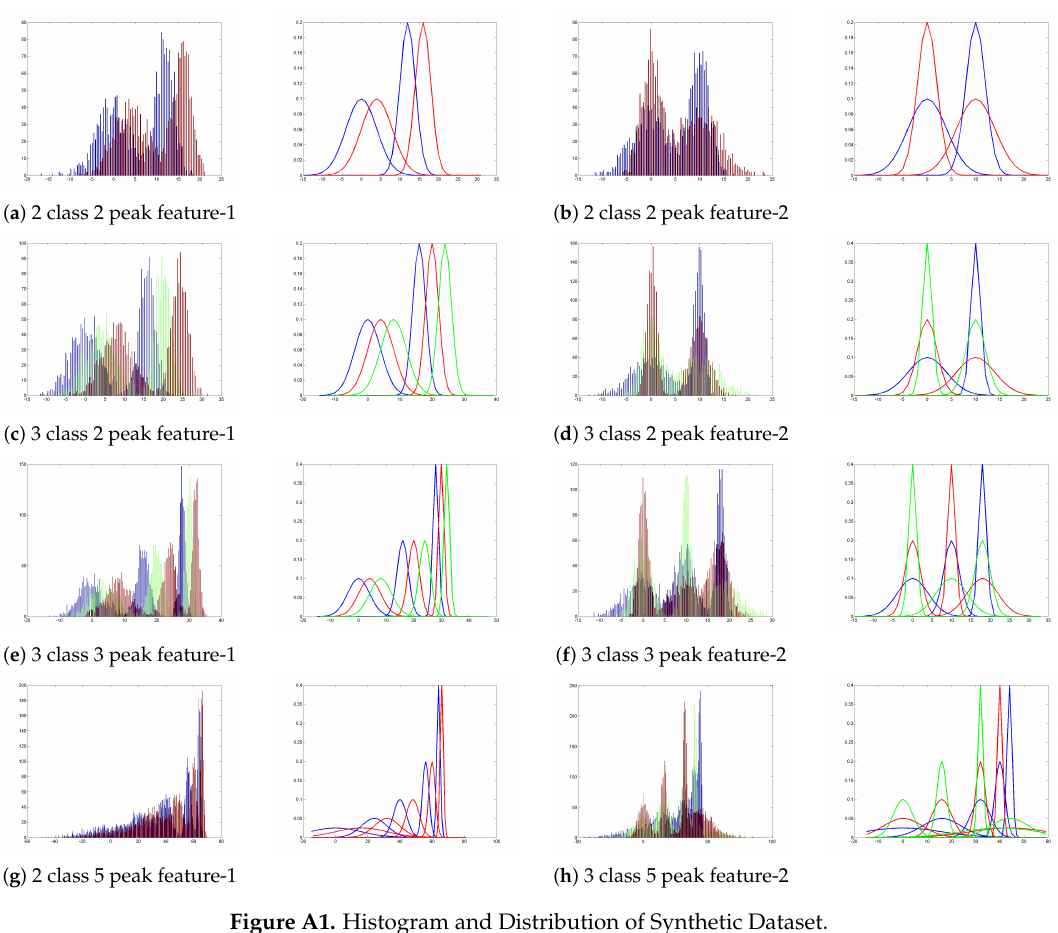
Figure A1. Histogram and Distribution of Synthetic Dataset.